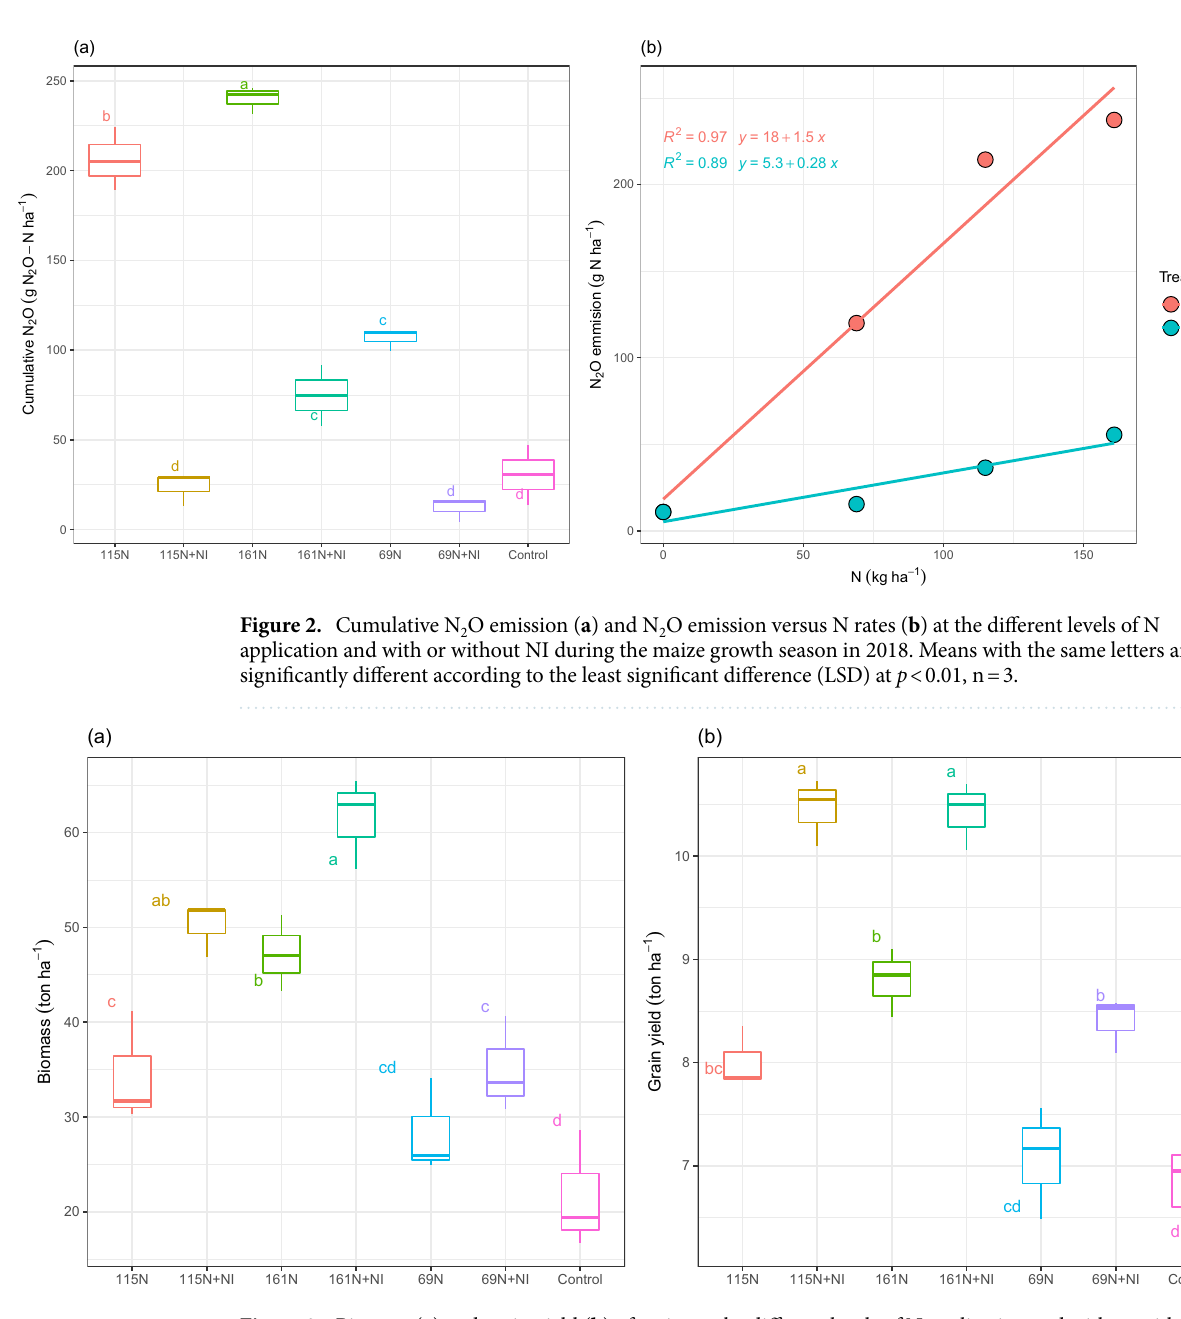
Figure 3. Biomass ( a ) and grain yield ( b ) of maize at the different levels of N application and with or without NI during the maize growth season in 2018. Means with the same letters are not significantly different according to the least significant difference (LSD) at p < 0.01, n =